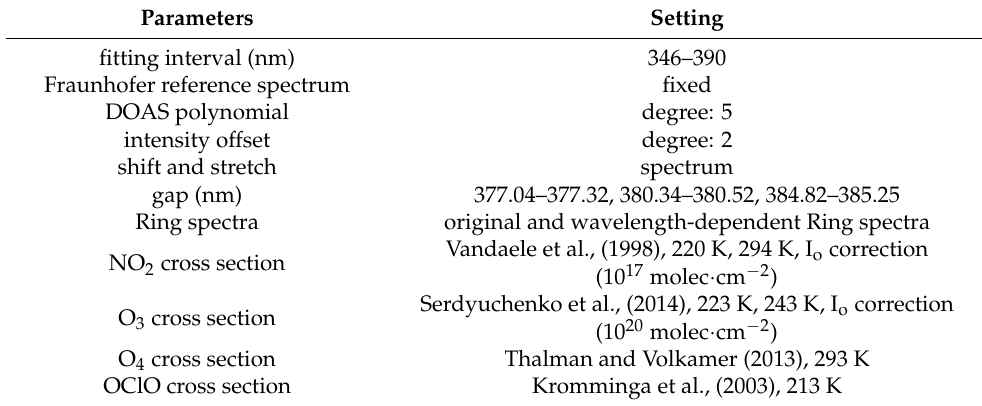
Table A4. Fit settings for the OClO spectral